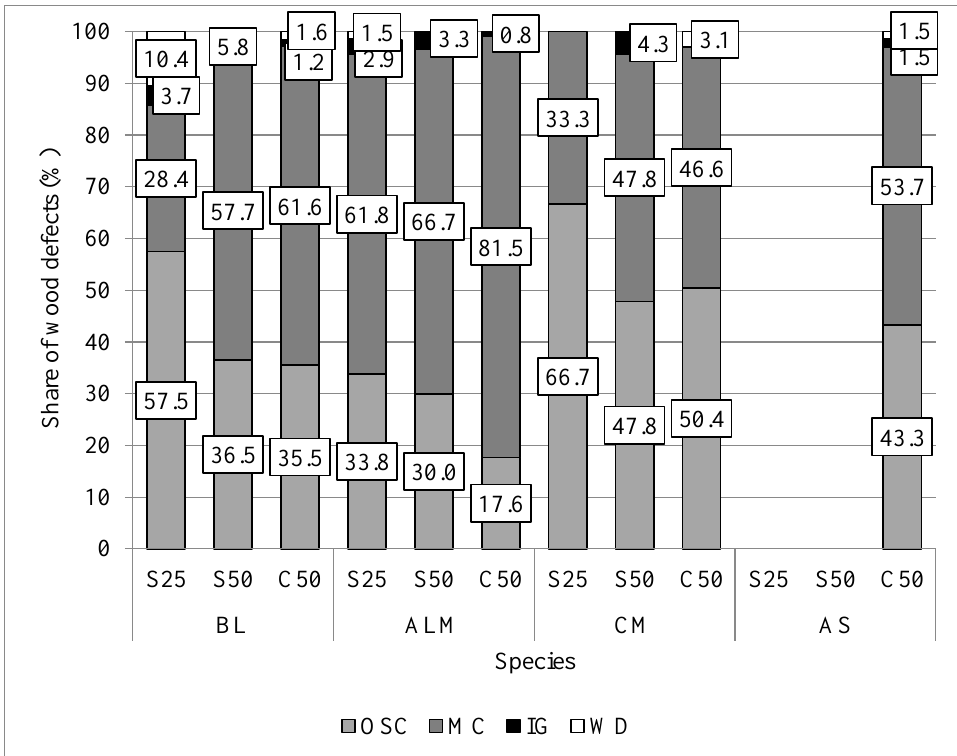
Figure 7. Share of wood defects influencing the result of timber quality classification in the studied tree species in the individual groups of research plots. Notes: BL — black locust; ALM — ash-leaf maple; CM — common maple; AS — American ash; S25 — combustion waste covered with sewage sludge, 25 cm thick; S50 — combustion waste covered with sewage sludge, 50 cm thick; C50 — clay-covered combustion waste; OSC — one-sided curvature; MC — multilateral curvature; IG — insect galleries; WD — without defects.